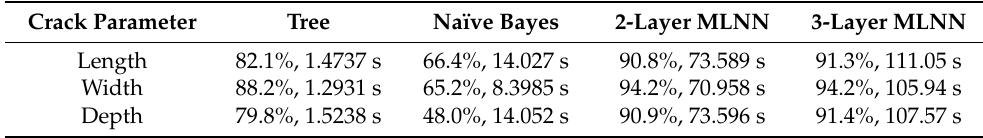
Table 4. Machine learning techniques accuracy for crack sensing.